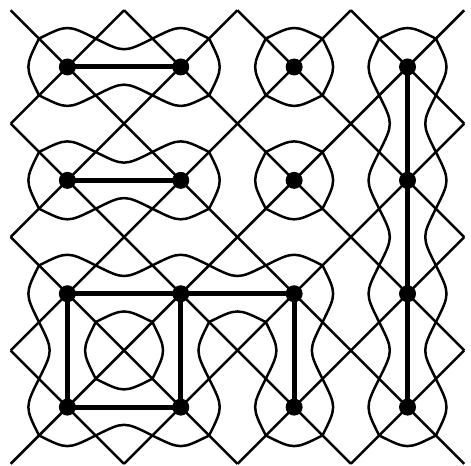
Figure 1 . A configuration of the Potts model in the loop/cluster formulation on the square lattice. The black dots are the loci of Q -component Potts spins σ . The thick bars form clusters, whose i total size is denoted | G | in (2.3). Cluster configurations are in one-to-one correspondence with their surrounding loop configurations, shown as thin curves in the figure. Each pair of (horizontally or vertically) neighbouring black dots resides diagonally around a tile, in whose interior two pieces of loops split in one of two possible